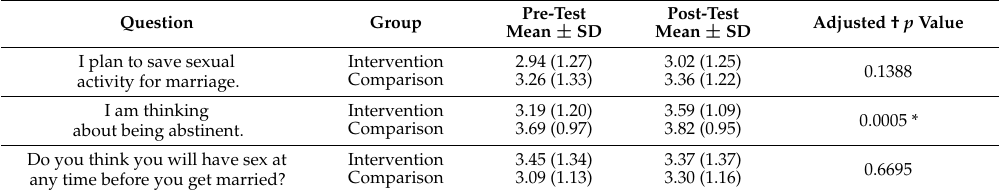
Table 3. Generalized linear model for behavioral intention to abstain from sexual intercourse. Question Group Pre-Test Mean ± SD Post-Test Mean ± SD Adjusted † p Value